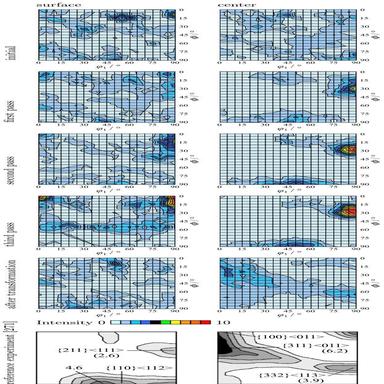
Texture evolution at the surface and at the center of the simulated rolled sheet in terms of Orientation Distribution Function (ODF) sections at = ° 45 2 . Figure adopted from with permission from the Iron and Steel Institute of Japan.